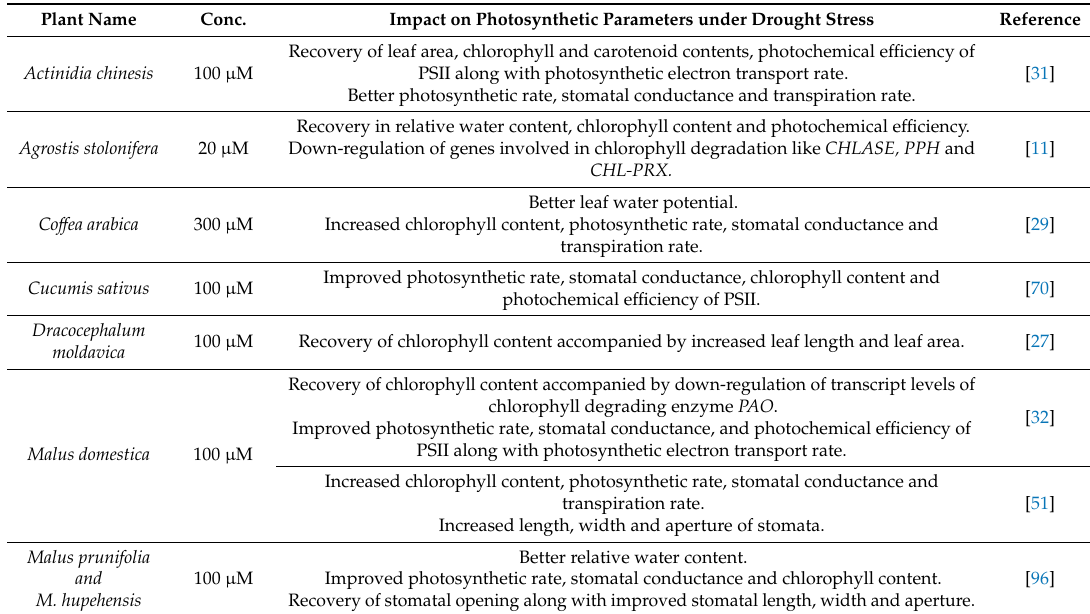
Table 1. Summary table explaining the e ff ect of exogenous applied melatonin on various photosynthetic parameters under drought